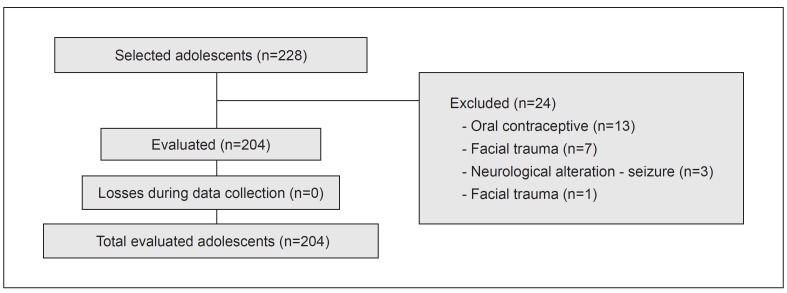
Eligibility diagram